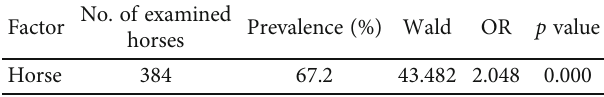
Table 1: Descriptive analysis of Strongylosis. No. of examined Factor horses